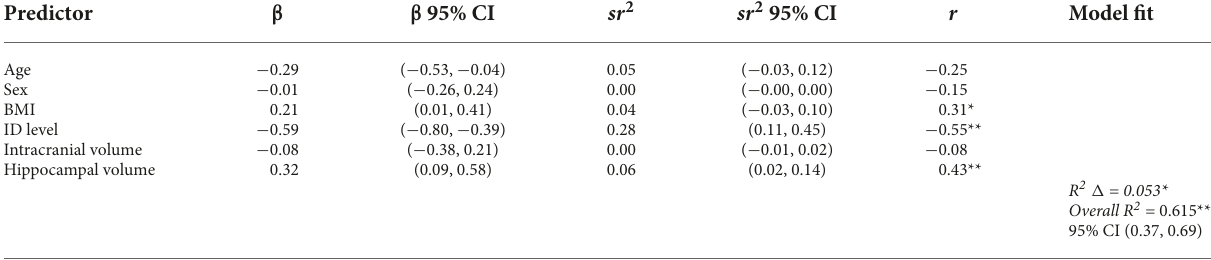
TABLE 6 Regression model of the relationship between total hippocampal volume and memory composite score ( n = 54).